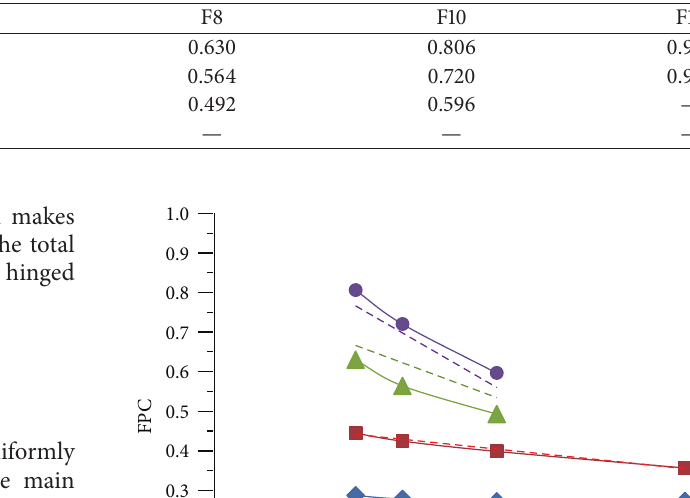
Table 4: 𝐸 𝐻 dissipated by the connections with respect to the total 𝐸 𝐻 .